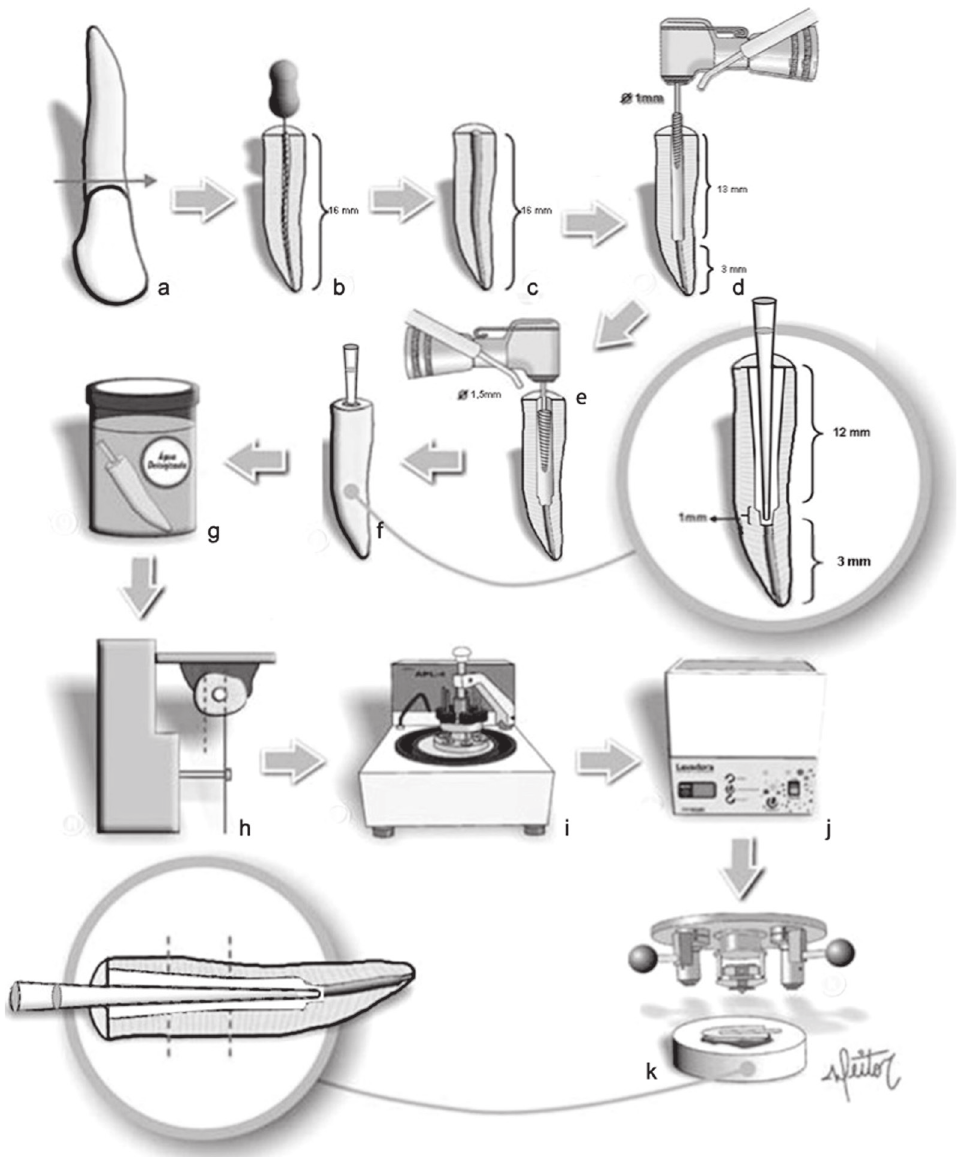
Figure 1- Schematic flow chart of the experimental steps: a: sectioning the bovine roots to the length of 16 mm; b,c: endodontic treatment; d: post space preparation with 1 mm-diameter bur to the length of 13 mm; and e: enlargement of post space with1.5 mm-diameter bur to the length of 12 mm; f: post cemented using either one of the cements; g: specimens stored in water for either 7 days or 3 months; h: root sectioning to expose the cement line; i: surface polishing for hardness measurements; j: ultrasound cleaning of specimens; k: microhardness indentations placed along the cement